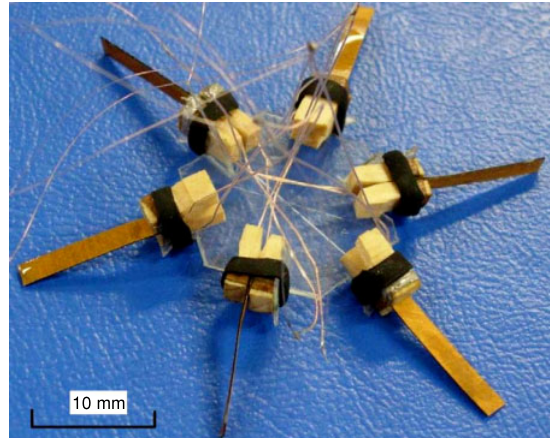
Figure 10 The outline of Walker-2.